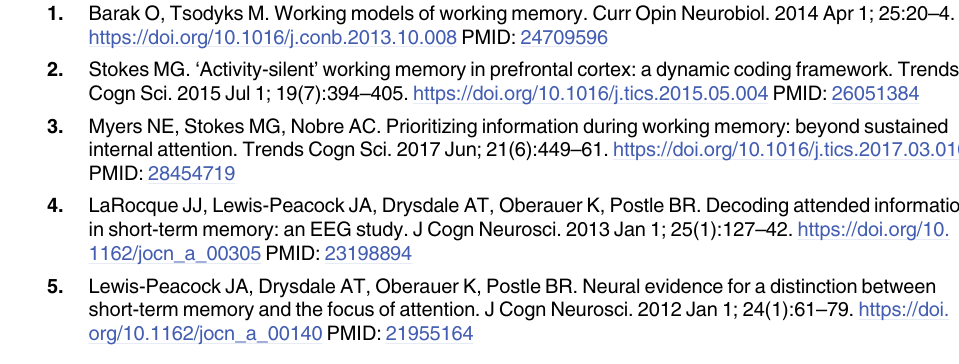
(PEV) by top dPCs of the UMI and PMI subspaces for 7D RNN, 60D RNN and EEG data. The percentages of both stimulus and global variance explained are